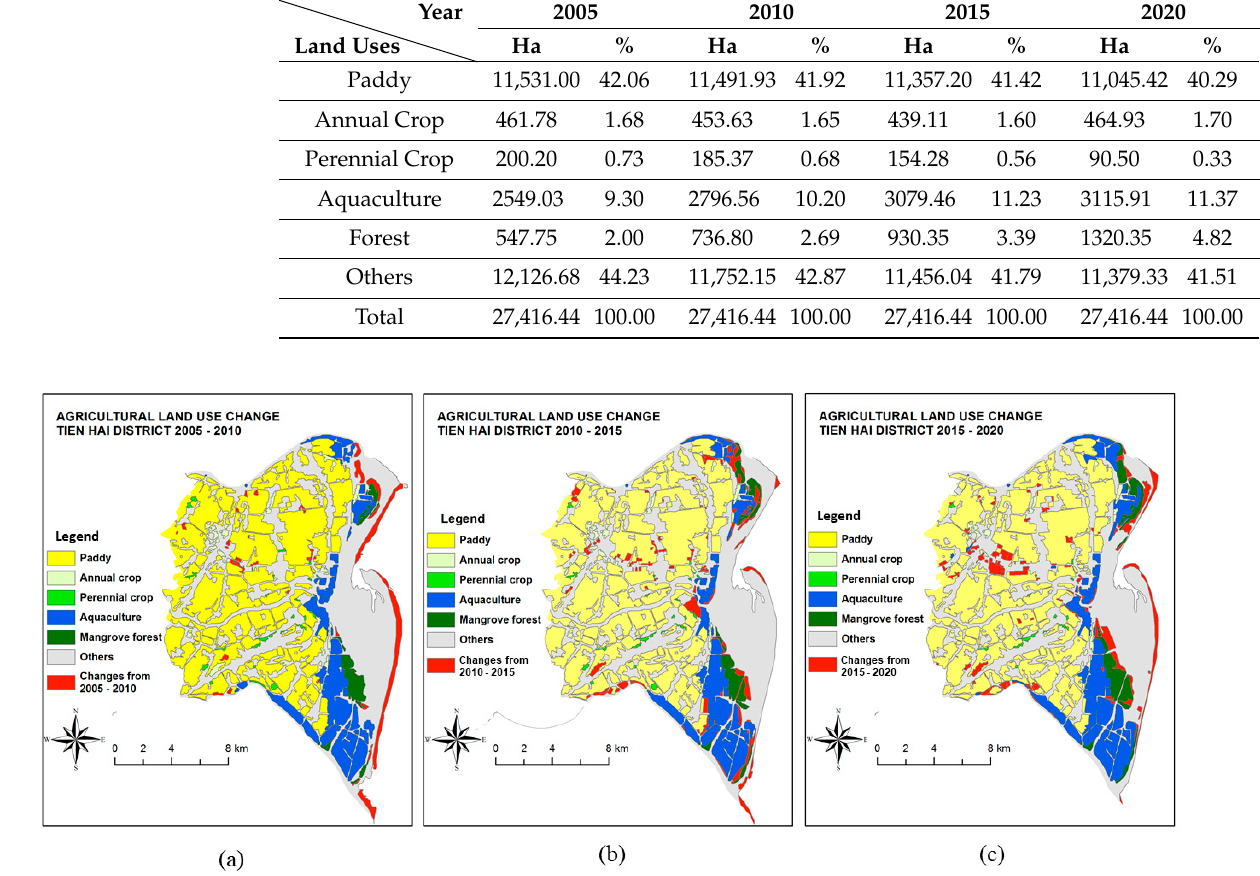
Figure 3. Land-use change map of Tien Hai district in three time periods ( a ) 2005–2010; ( b ) 2010–2015; ( c ) 2015–2020.